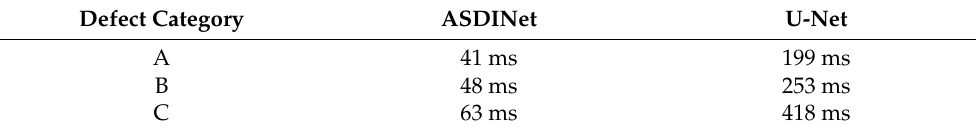
Table 13. The average detection time of U-Net and ASDINet in the three cases of A, B, and C. Defect